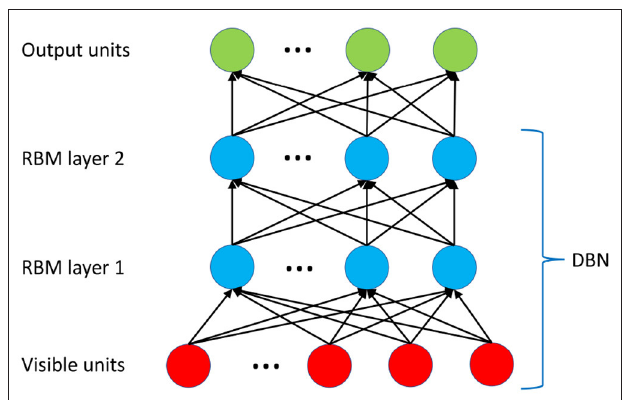
FIGURE 4 | The deep architecture of the DBN. Two layers of RBM are trained in an unsupervised manner (pre-trained) using CD-1 algorithm. The top layer utilizes a neural network sigmoid regression for the